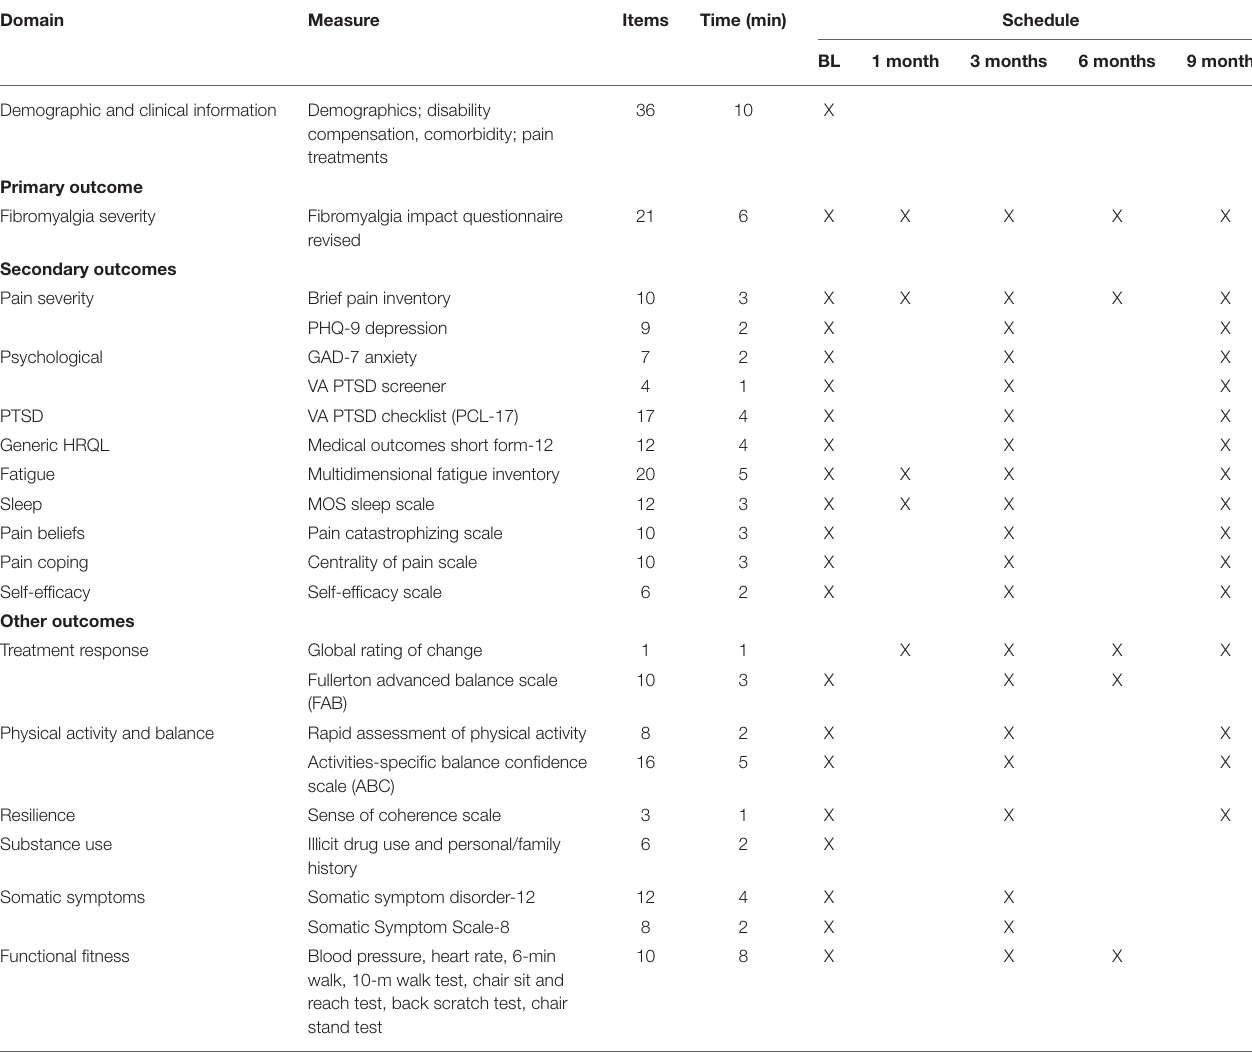
TABLE 1 | Outcome assessment protocol: measures and schedule of administration.